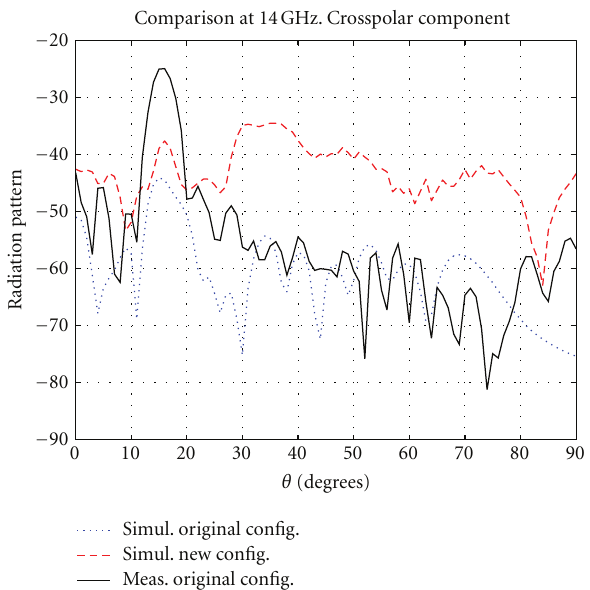
Comparison at 14 GHz. Crosspolar component